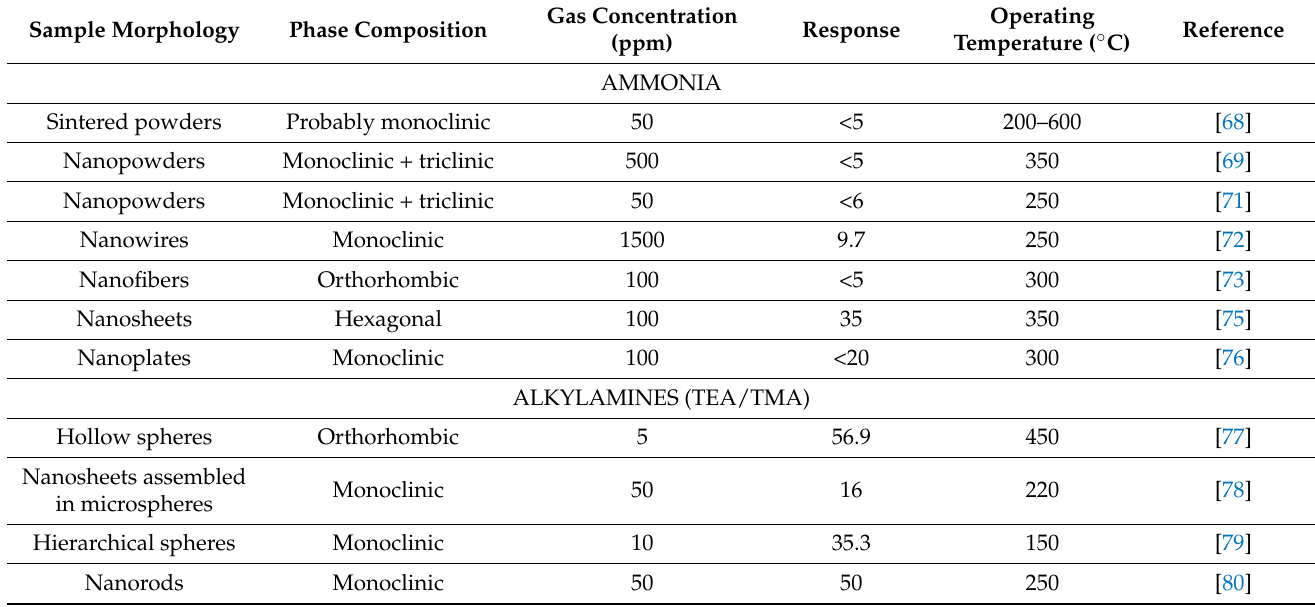
Table 3. Summary of the main features of the WO 3 -based ammonia and amines sensors described in Section 2.3.